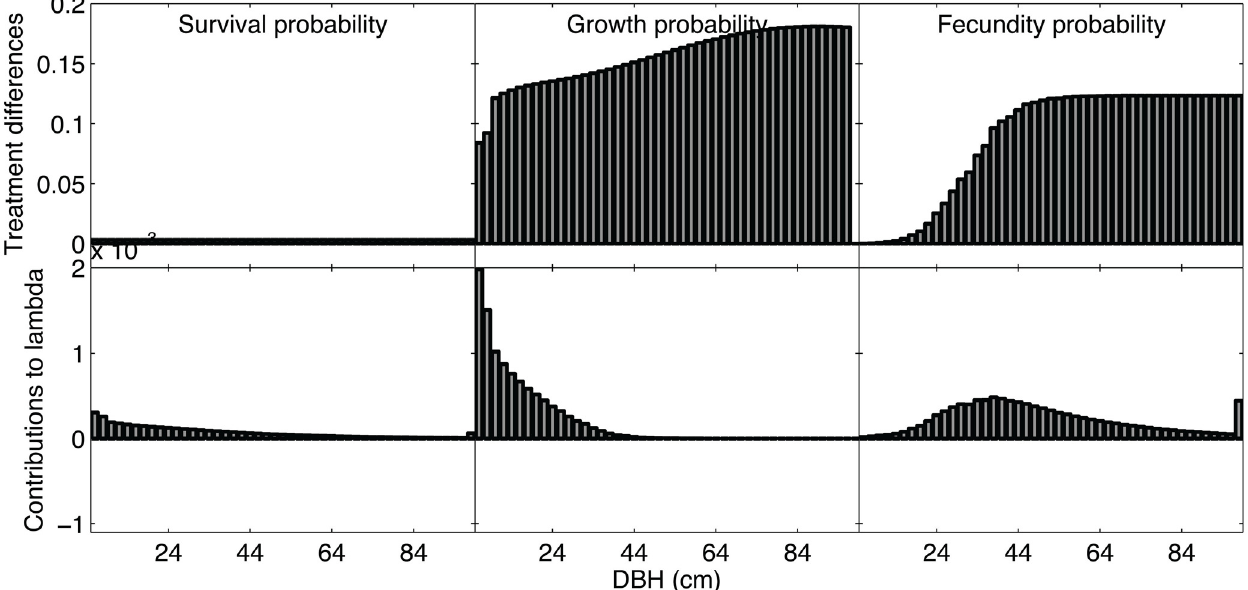
Fig 1. LTRE for M . paraensis demonstrating demographic differences between harvested and unharvested plots and their contributions to population growth.